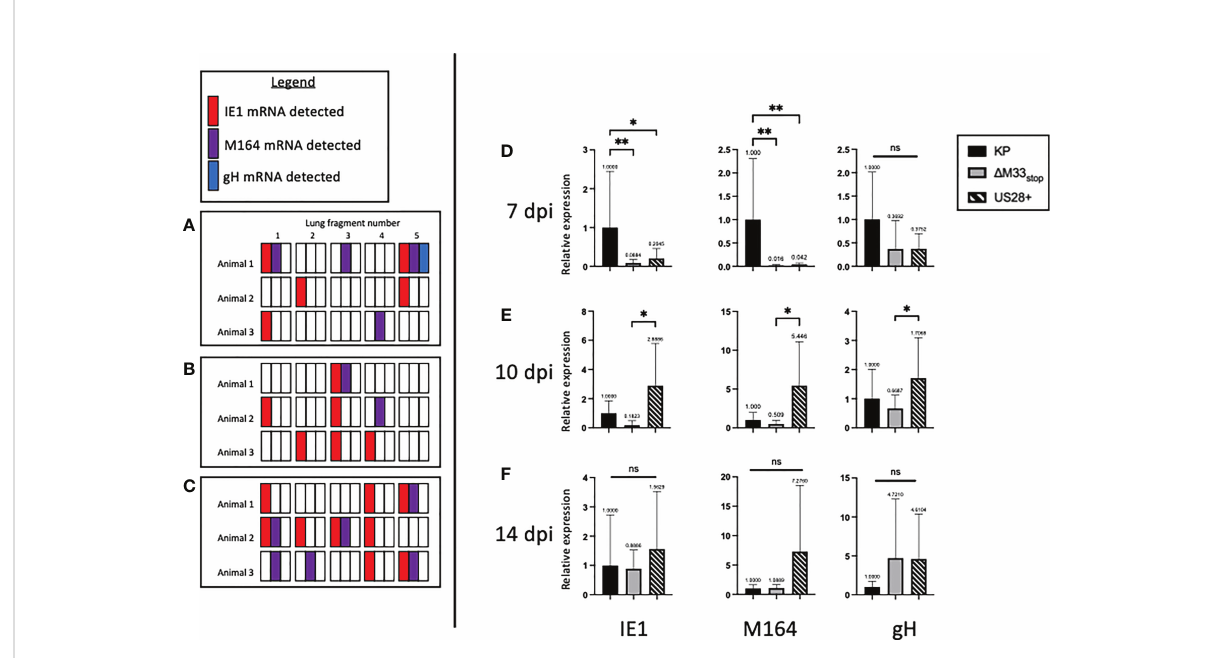
FIGURE 6 M33 is required for progression to b - and g -phase genes and US28 partially complements its effects. Latently-infected BALB/c mice were sacri fi ced at 70 dpi and the lungs were divided into 5 lobes. RNA was puri fi ed from lung tissues, and RT-PCR was performed to detect viral RNA transcripts. Each square represents one lobe, and each row of squares represents one animal (n=3). (A-C) Presence or absence of IE1 (red), m164 (purple), or gH (blue) mRNA in lung lobes of mice latently infected with KP (A) , D M33 stop (B) , or US28 + (C) . (D-F) Lungs from latently- infected mice were explanted and RNA puri fi ed at 7 dpe (D) , 10 dpe (E) , and 14 dpe (F) . Data are normalized to KP (black bar) and shown as relative expression compared to GAPDH housekeeping gene. Signi fi cance shown as *p<0.05; **p<0.01; ns, not signi fi cant. If no comparisons are indicated, no signi fi cance was detected. A-C, n=3 mice; D-F, n=2 mice divided into 3 replicate wells